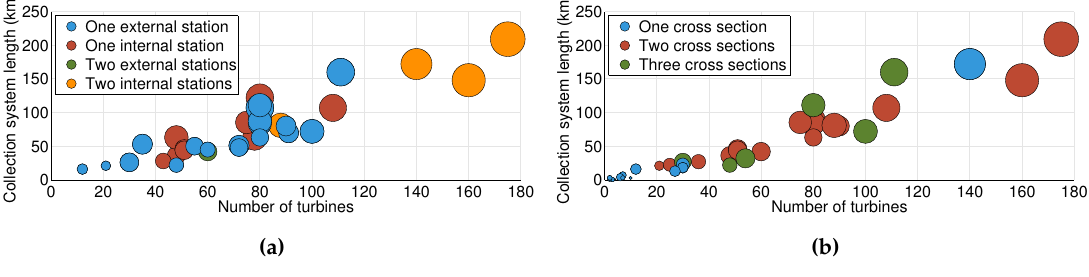
Figure 10. Statistics for commissioned and under construction European OWFs [10,11,54]. Circle size represents the installed capacity of the wind farms; ( a ) Number and location of offshore substations; ( b ) Number of different collection